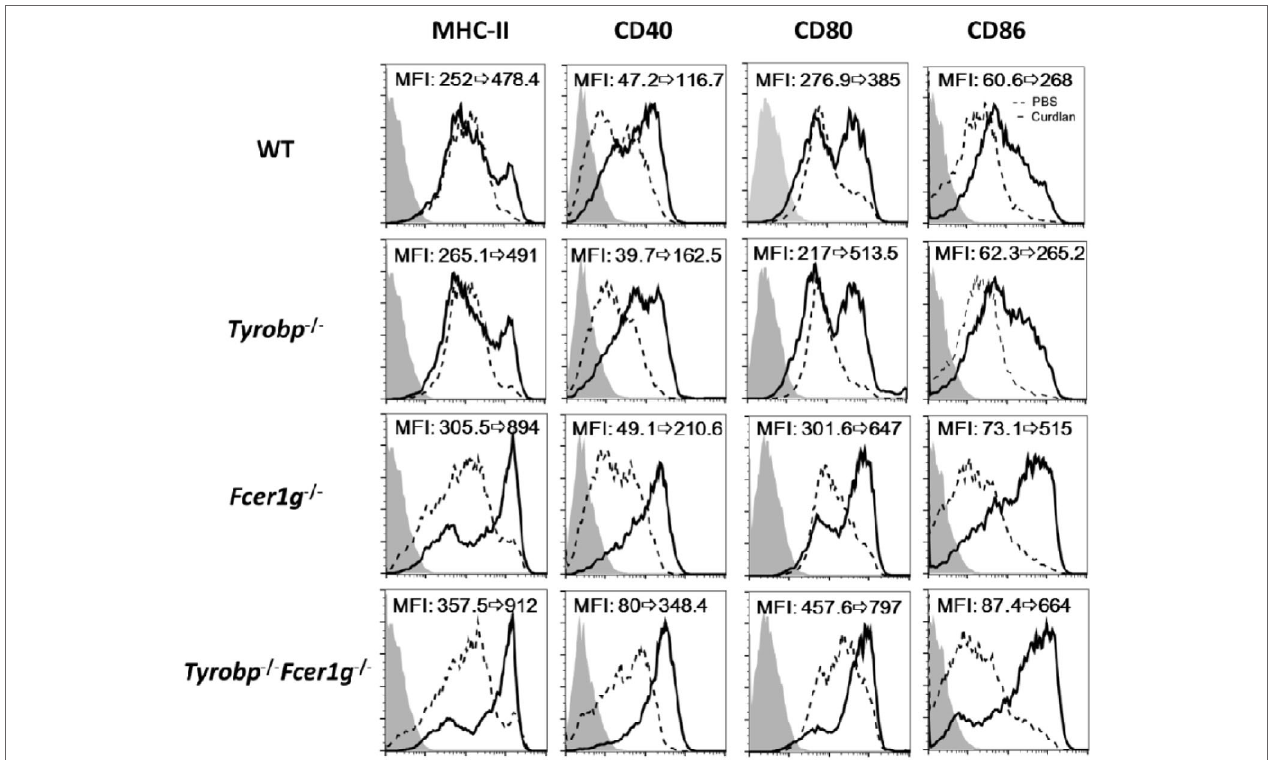
FigUre 1 | Enhancement of maturation in Fcer1g − / − and Tyrobp − / − Fcer1g − / − DCs after Dectin-1 activation. BMDC derived from WT, Tyrobp − / − , Fcer1g − / − , and Tyrobp − / − Fcer1g − / − mice were cultured in RPMI containing 10% FBS and 10 ng/mL mGM-CSF, and then treated with PBS (dash line) or curdlan (10 µg/mL, solid line) on day 6. After 16 h, DCs were harvested and the maturation was determined by flow cytometry for the expression of MHC-II, CD40, CD80, and CD86. The changes of mean fluorescent intensities (MFIs) from control to treatment are indicated in each histogram. Gray areas represented the isotype-matched Ig controls. Data shown are representative from three independent